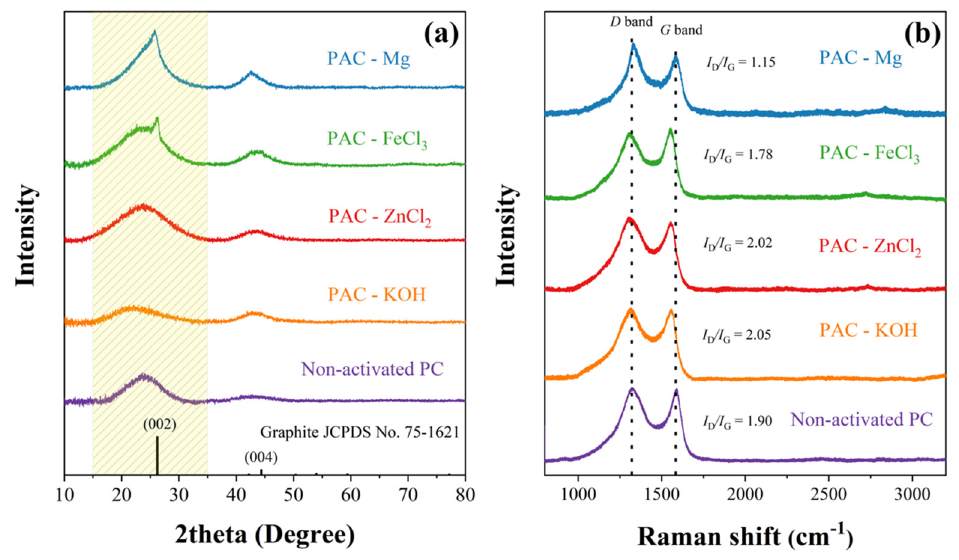
Figure 1. ( a ) XRD patterns and ( b ) Raman spectra of non-activated PC and PAC samples with different activating agents.